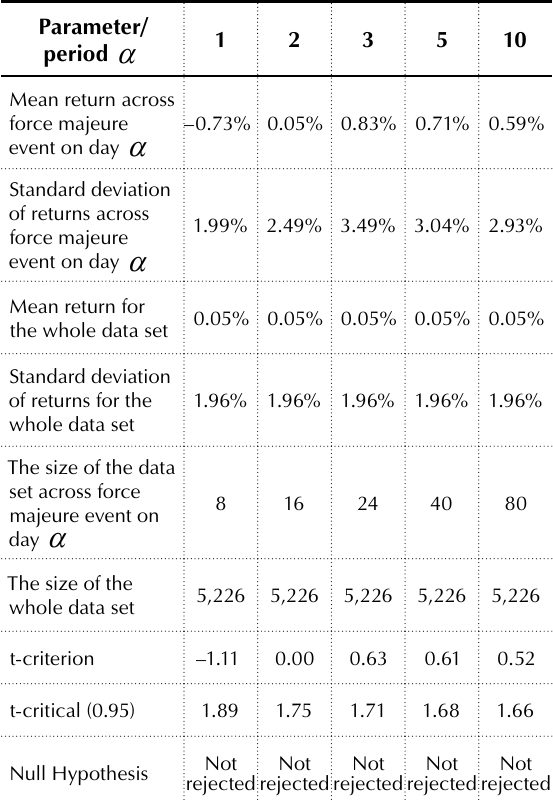
Table 7. T -test for the PFST returns over the period 1991–2018: social force majeure and